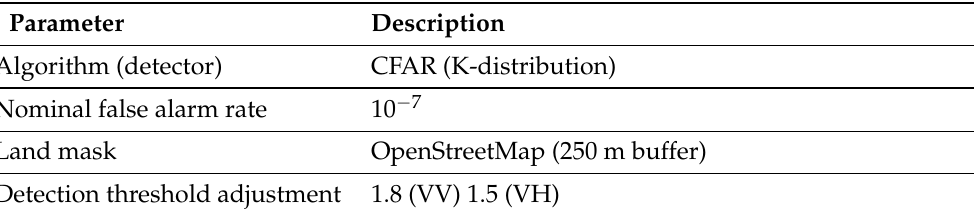
Table 1. SUMO: SAR processing